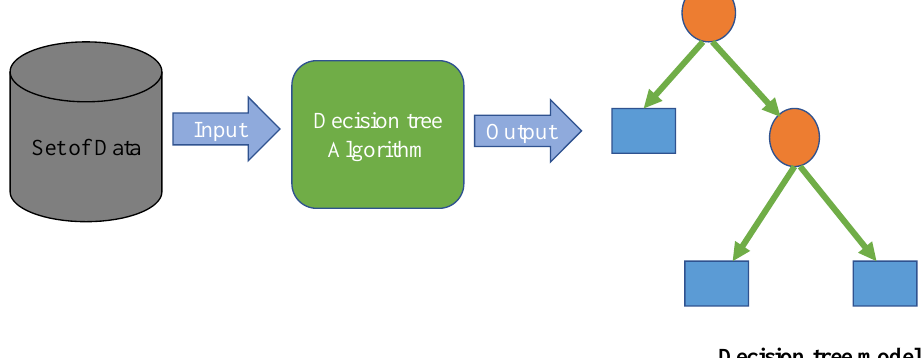
Figure 6. Flow chart indicating the executing process of the decision tree.